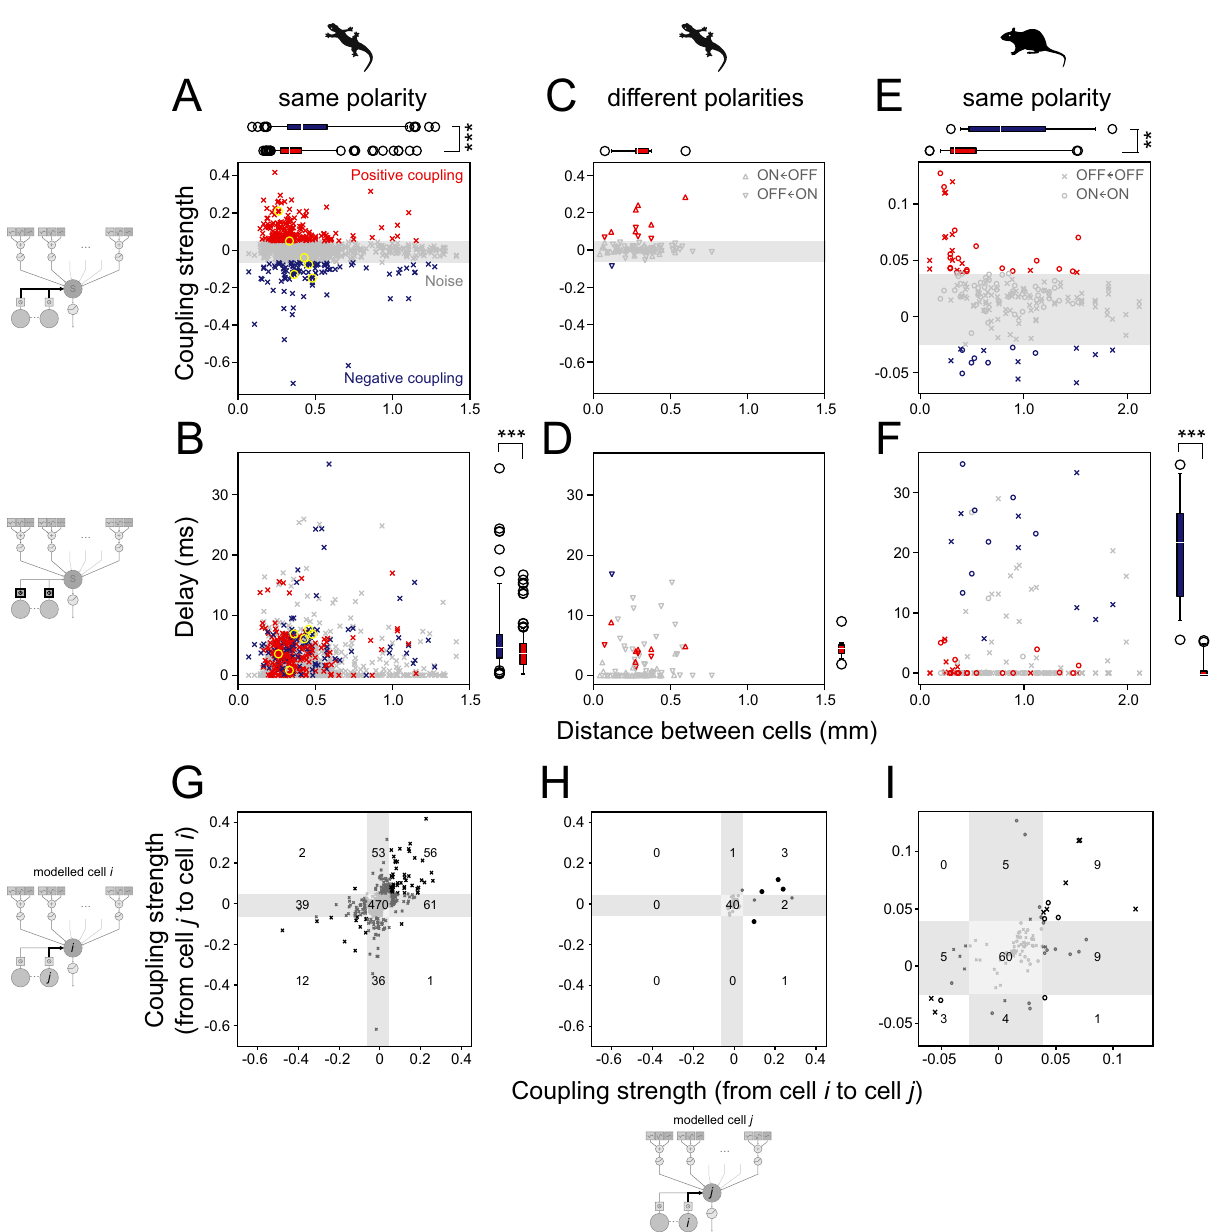
Fig 3. Coupling model predicts faster enhancing effects among proximal retinal ganglion cells and slower suppressing effects among distal cells. (A, B) Coupling strength (A; a k in Eq (2) in Methods) and delay (B; l k in Eq (1) in Methods) parameter values from the LNSCN model plotted as a function of the distance between salamander retinal ganglion cells of the same response polarity (crosses, OFF cells coupled with OFF neighbors, N = 1460; yellow circles, representative cases in Fig 1B–1D). The noise level was determined by shuffling analysis (gray, 0.5 and 99.5 percentile; see Methods for details). Positive couplings (red, N = 211) were found at a shorter distance (A; 0.31 ± 0.14 mm versus 0.40 ± 0.26 mm; median ± interquartile range as shown by the box plot; p < 0.001, rank-sum test) with a shorter latency (B; 3.5 ± 3.6 ms versus 4.6 ± 4.0 ms; p < 0.001) than negative couplings (blue, N = 98). (C, D) Corresponding figure panels for salamander cells with different response polarities (down-pointing triangles, OFF cells with ON neighbors, N = 47; up-pointing triangles, ON cells with OFF neighbors, N = 46). Couplings above the noise level were mostly positive ( N = 10) with the distance of 0.28 ± 0.08 mm (C; median ± interquartile range) and the latency of 4.2 ± 1.5 ms (D). (E, F) Corresponding figure panels for mouse retinal ganglion cells of the same response polarity (circles, ON cells coupled with ON cells, N = 76; crosses, OFF cells coupled with OFF cells, N = 116). Positive couplings (red, 18 ON and 15 OFF cell pairs) were found at a shorter distance (C; 0.33 ± 0.25 mm versus 0.78 ± 0.74 mm; p = 0.002) and with a shorter latency (D; 0.0 ± 0.0 versus 21.9 ± 13.8 ms; p < 0.001) than negative couplings (blue, 7 ON and 9 OFF cell pairs). Data not analyzed for the mouse cells with different response polarities because the coupled model performance did not show an improvement (Fig 2B). (G–I) Comparison of the coupling strengths from one cell to another and vice versa (black, couplings above the noise level in both directions; dark grey, above the noise level only in one direction; light gray, both below the noise level). The number of data points in each category is shown in the figure panels. Symmetric, either